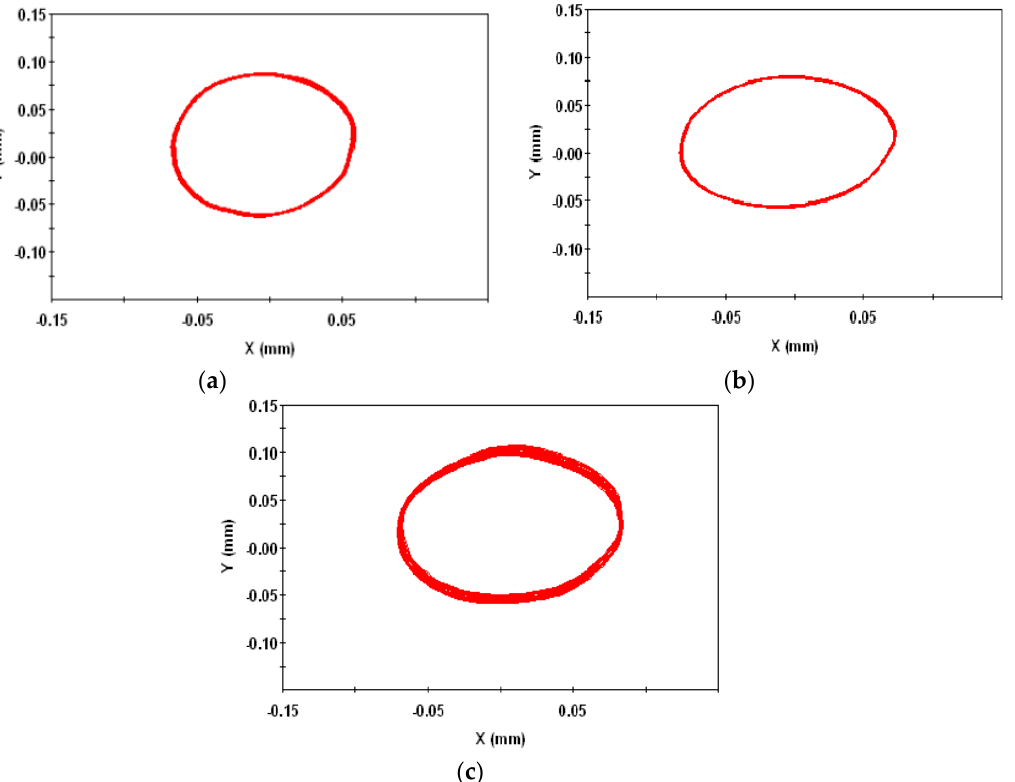
Figure 20. Orbit of rotor at ( a ) 2000 rmp, ( b ) 4000 rmp and ( c ) 4500 rpm